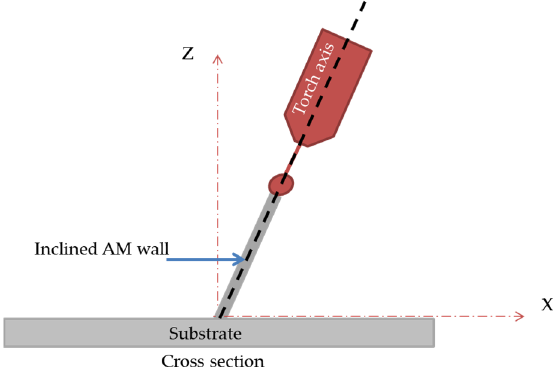
Figure 5. Manufacturing of an inclined thin wall by using torch axis orientation.